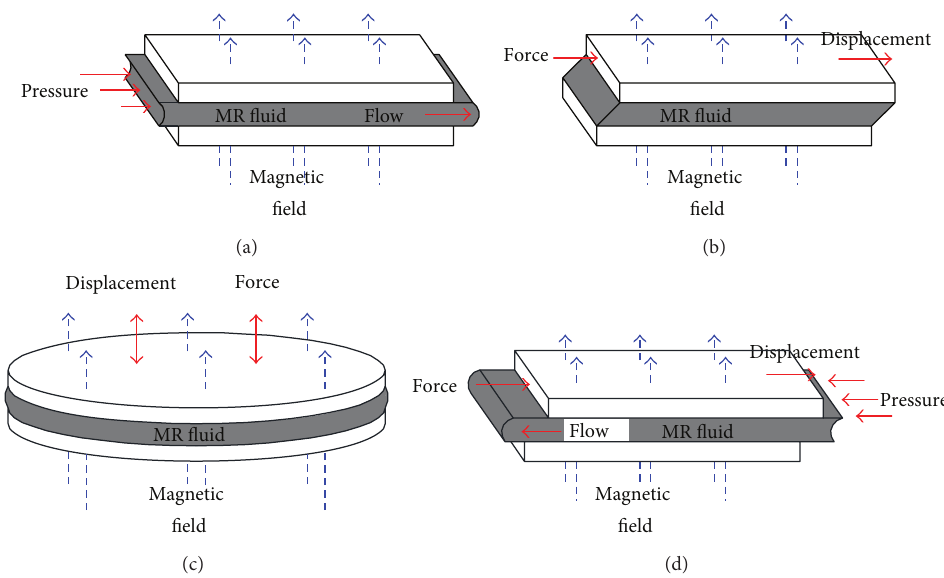
Figure 1: MR fluid flow modes: (a) valve mode, (b) shear mode, (c) squeeze mode, and (d) valve and shear mode.